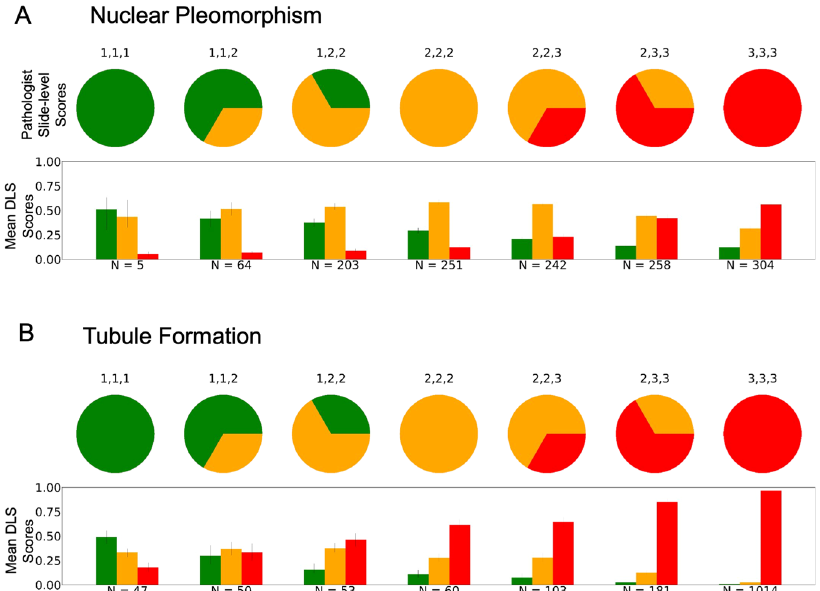
Fig. 3 Assessing slide-level classi fi cation of nuclear pleomorphism and tubule formation. The three pathologist scores provided for nuclear pleomorphism ( A ) and Tubule Formation ( B ) for each slide are represented by the pie charts. Bar plots represent the model output for each possible component score with the mean output plotted for the cases matched to those represented by the corresponding pie chart. Green corresponds to component score of 1, yellow to component score of 2, and red to component score of 3. Error bars are 95% CI. DLS Deep Learning